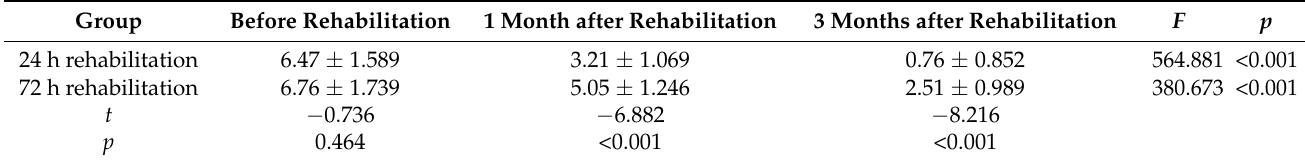
Table 1. The NIHSS scores of with acute ischemic stroke patients before and after rehabilitation ( x ± s, n = 75).